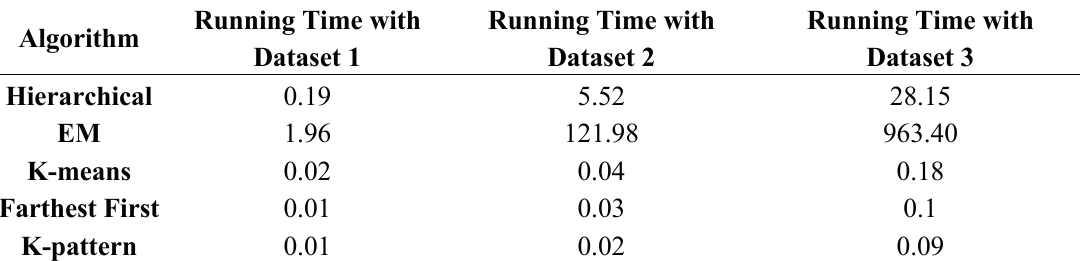
Table 3. Running time for cluster forming.